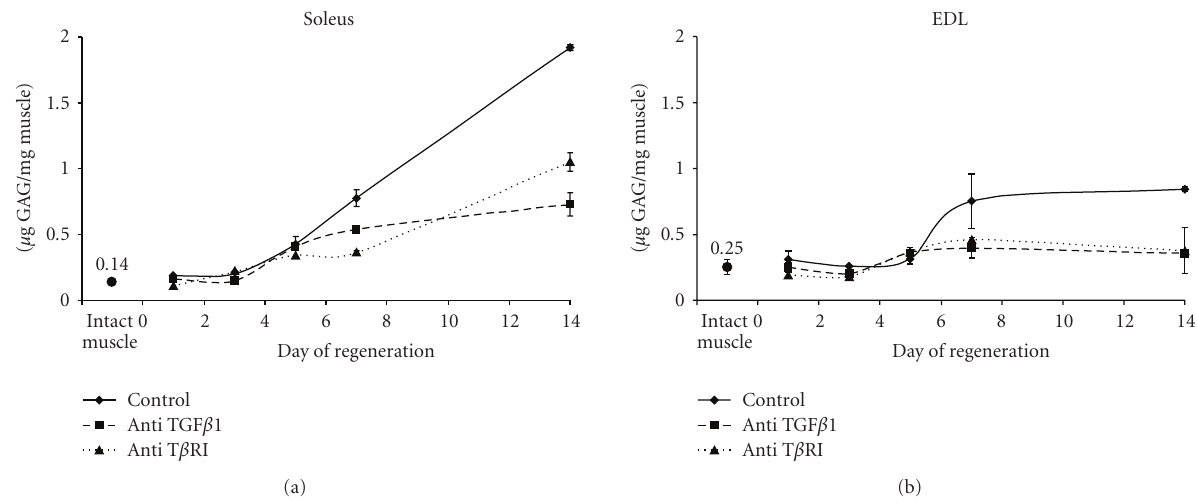
Figure 8: Sulphated GAGs content during soleus and EDL muscle regeneration . Total sulphated GAGs were measured using a method based on dimethylmethylene blue coprecipitation with GAGs (see Materials and Methods Section) in extracts from regenerating control treated with the indicated antibodies. Results are expressed as μ g of GAG per mg of muscle fresh weight ± SE. Results are means from 3 animals repeated 3